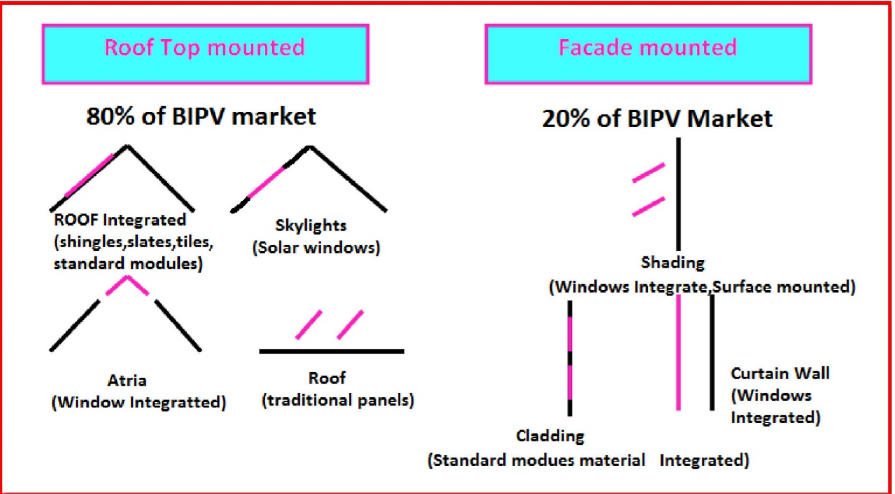
Figure 1. BIPV applications in sustainable building [7].